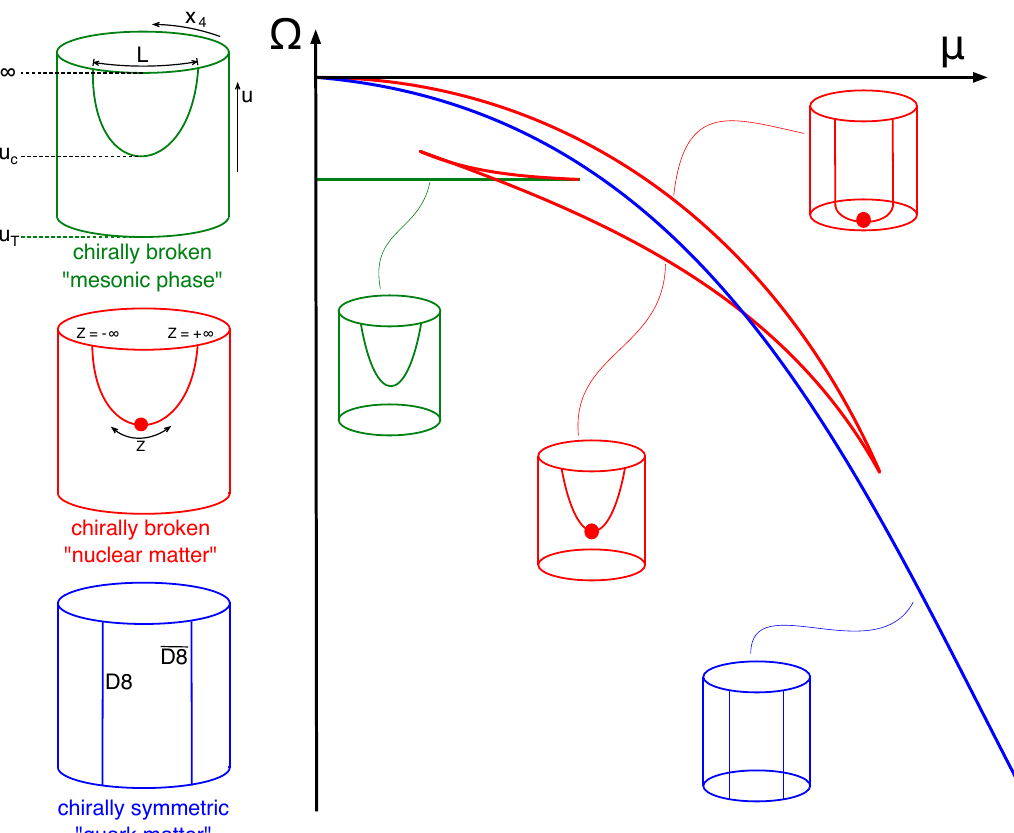
Figure 3 . Schematic plot of the free energy (cid:10) as a function of the chemical potential (cid:22) , showing the continuous path that connects nuclear matter with quark matter. The various branches are labelled by the geometry of the (cid:13)avor branes in the ( u; x 4 ) subspace, with the dot on the connected (cid:13)avor branes indicating the